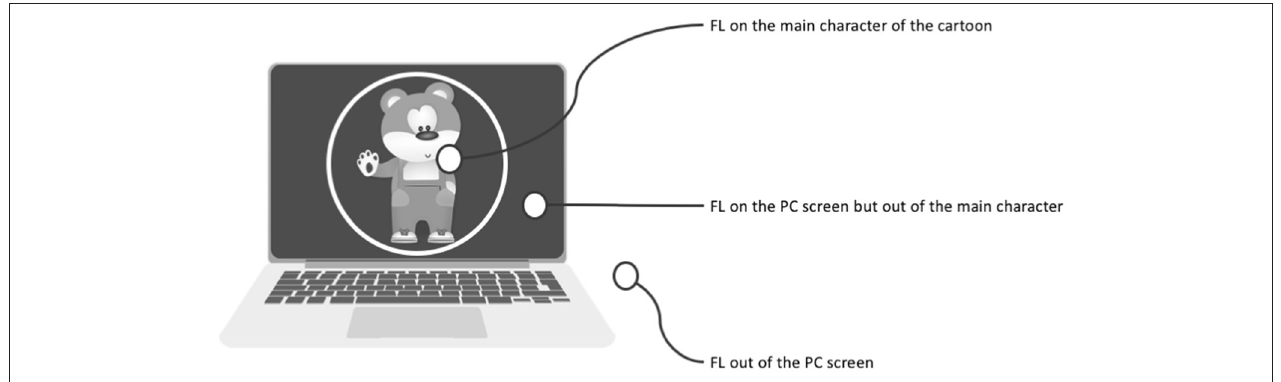
FIGURE 4 | Computation of the three different FL.